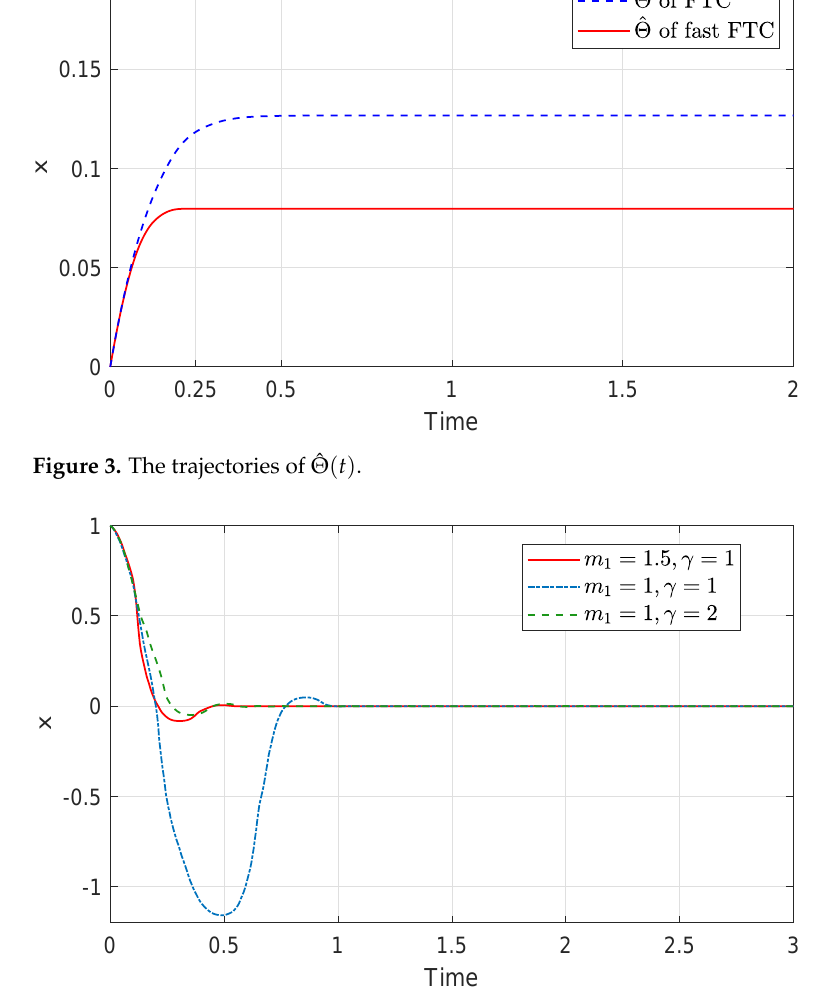
Figure 4. The trajectories of x 1 ( t )